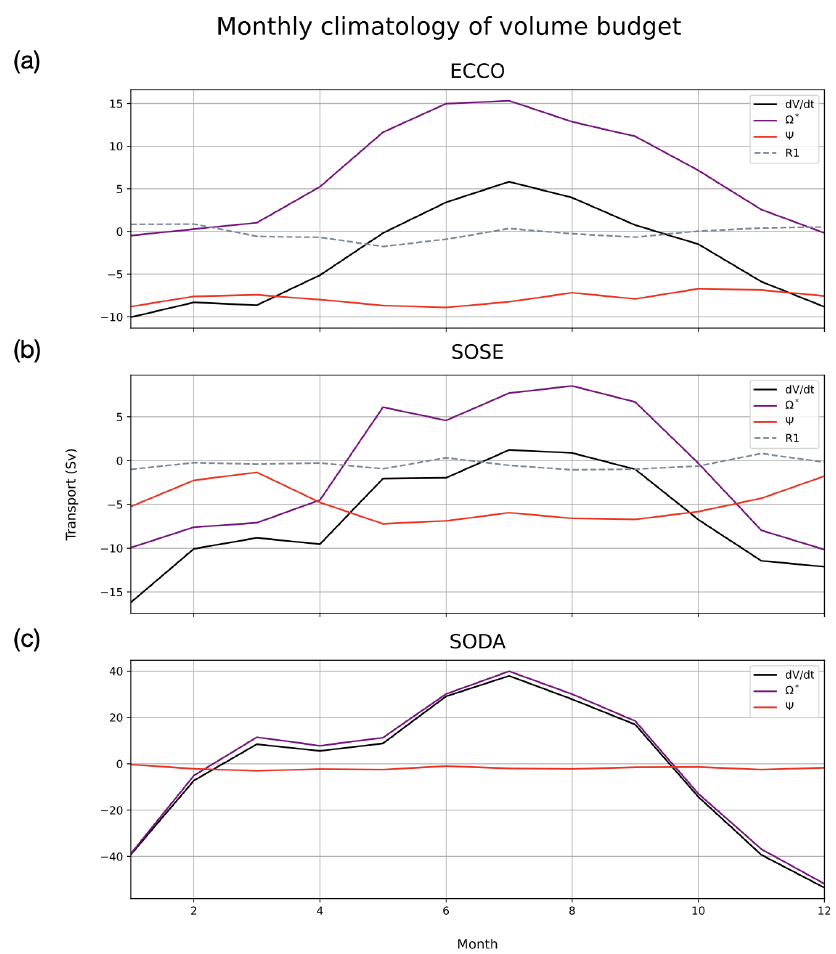
Figure 7. Monthly climatology of Weddell bottom water’s main WMT budget terms in ECCO (a) , SOSE (b) and SODA (c) . Residual due to discretization ( R 1) only shown in ECCO and